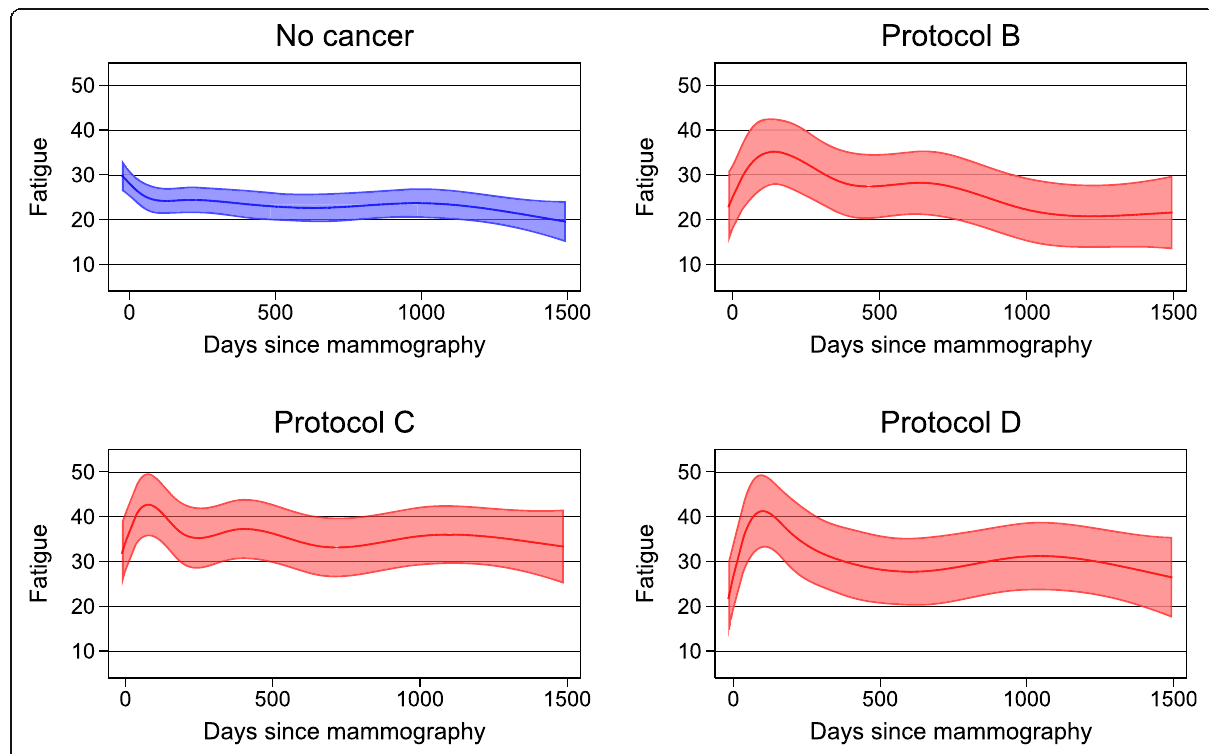
Fig. 5 Mean fatigue among women with breast cancer divided according to treatment regimes